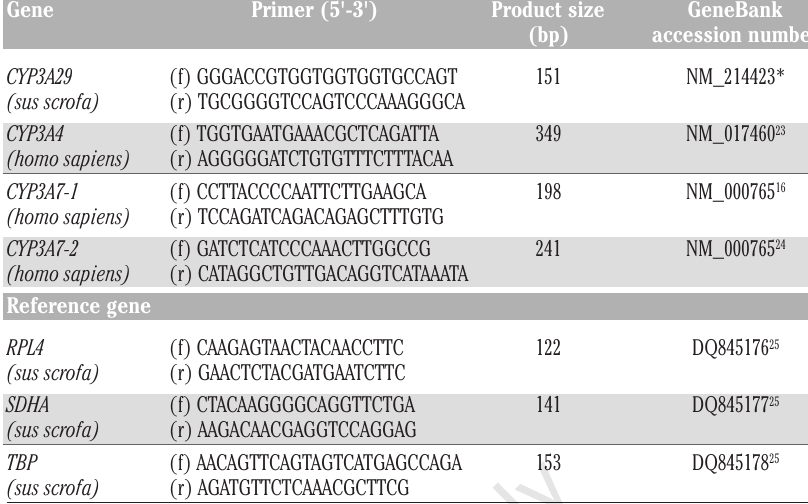
Table 1. Primers used for polymerase chain reaction, product size and species specificity of the